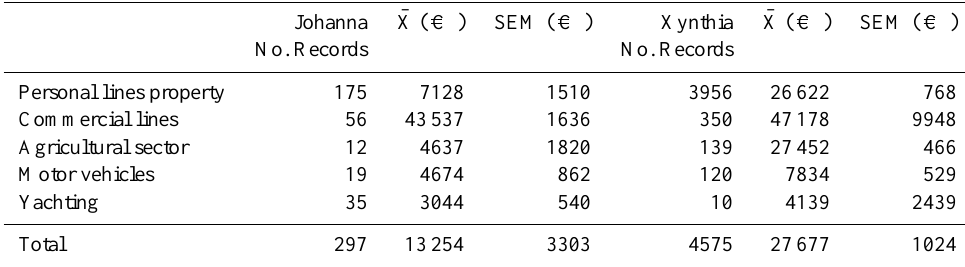
Table 1. Number of records, mean indemnities ( ¯ X) and standard error of the mean (SEM) per lines of business for Johanna and Xynthia storms, for the three insurance companies that took part in the study. The resulting dataset is believed to represent around 25% of the overall insurance market in